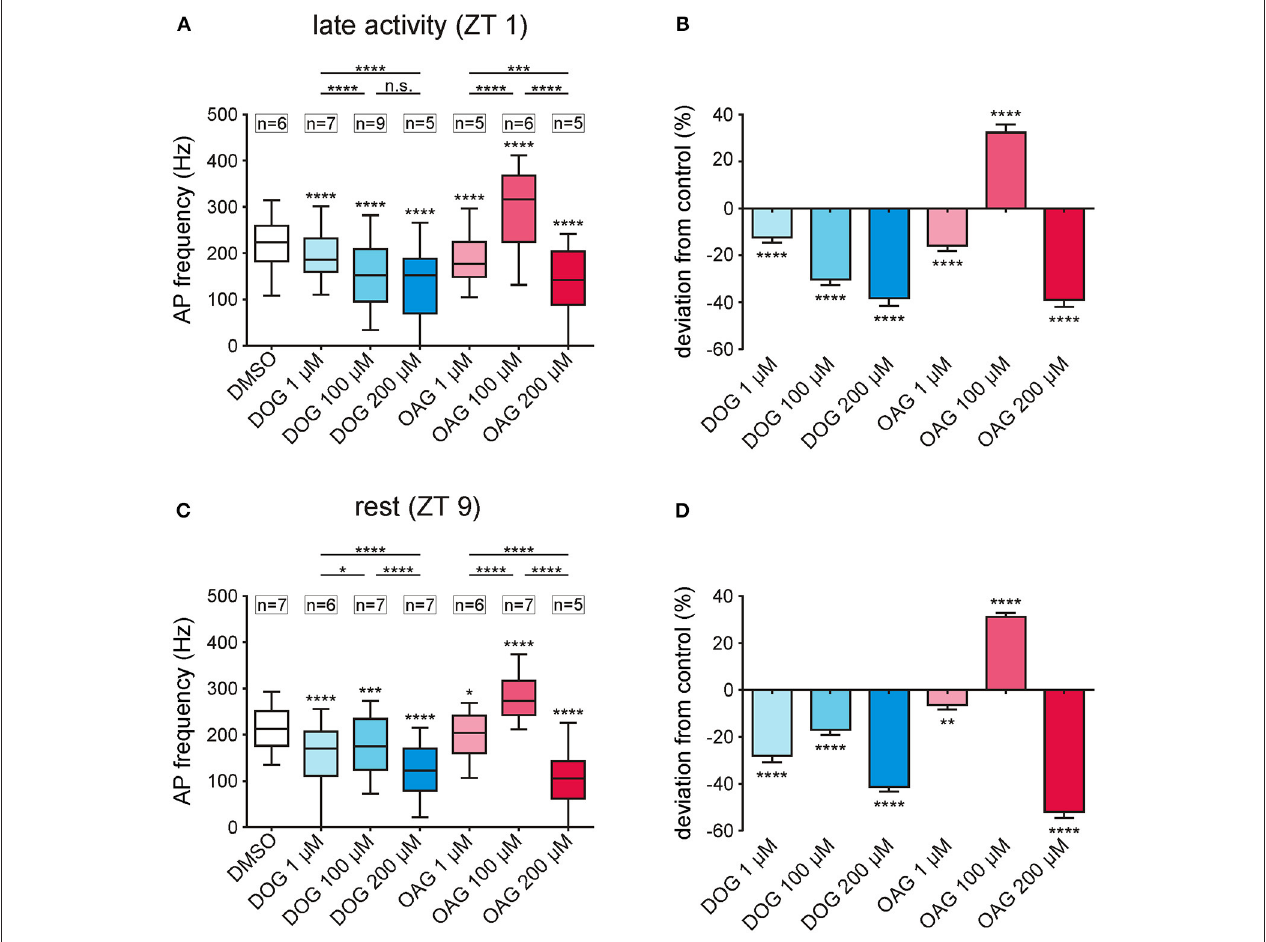
FIGURE 5 | Only 100 µ M OAG increased the phasic pheromone response while all other concentrations of both DAG-analogs caused reductions. (A,C) Box-plots show the phasic pheromone response [ = frequency of the first 6 bombykal-dependent action potentials (APs)] over the 2h recordings, with or without (control) infusion of different concentrations of DOG or OAG with 0.1% DMSO. A significant decrease in the phasic pheromone response was found for all concentrations of DOG (1, 100, 200 µ M) as well as for 1 and 200 µ M OAG at both Zeitgebertimes. Only application of 100 µ M OAG increased the phasic pheromone response significantly during the late activity phase and at rest. (B,D) The percentage change illustrates that the highest concentrations of either DAG-analog resulted in the strongest reduction of the AP frequencies in comparison to the controls. Solely 100 µ M OAG elevated the frequencies by about 30% in the late activity phase as well as during rest (for mean values ± SEM see S4; for exact P -values see S5; n.s. = not significant; * P < 0.05; ** P < 0.01; *** P < 0.001; **** P < 0.0001; Wilcoxon test, Mann-Whitney test or Kruskal-Wallis test with Dunn’s post-hoc test for multiple